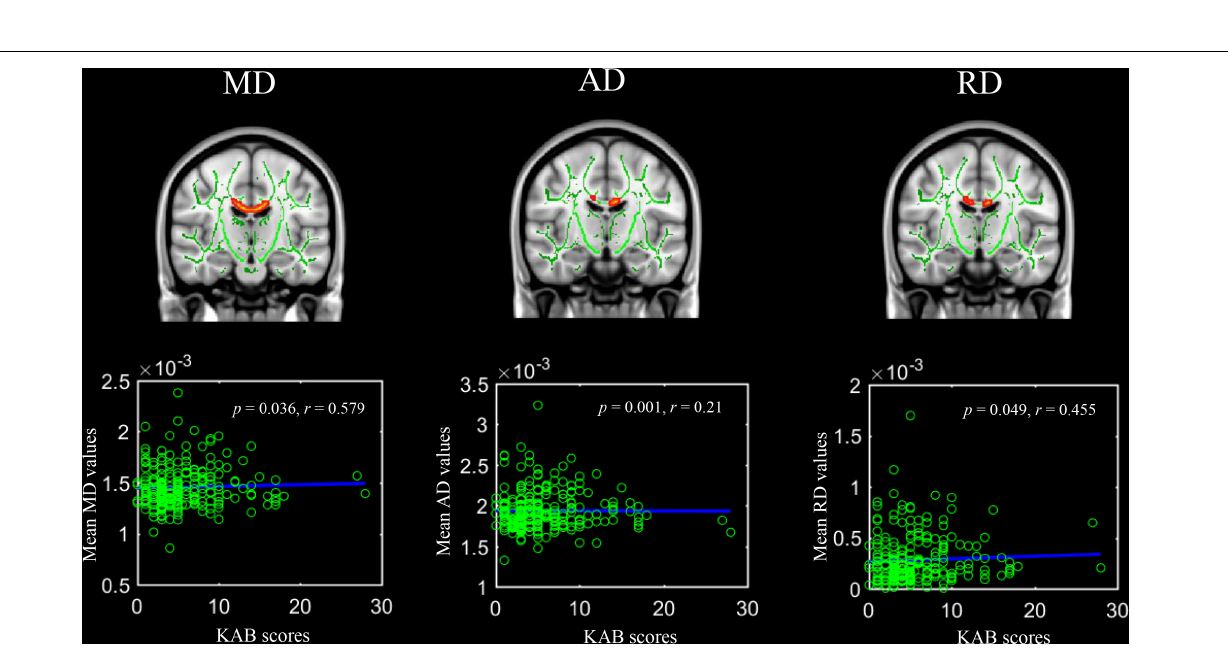
FIGURE 2 | Significant voxel-wise correlations between diffusion metrics of body of corpus callosum and current life stress level (Kurzfragebogen zur Aktuellen Beanspruchung, 5000 permutations, FWER at p < 0.05). Red color indicates significant positive correlations.